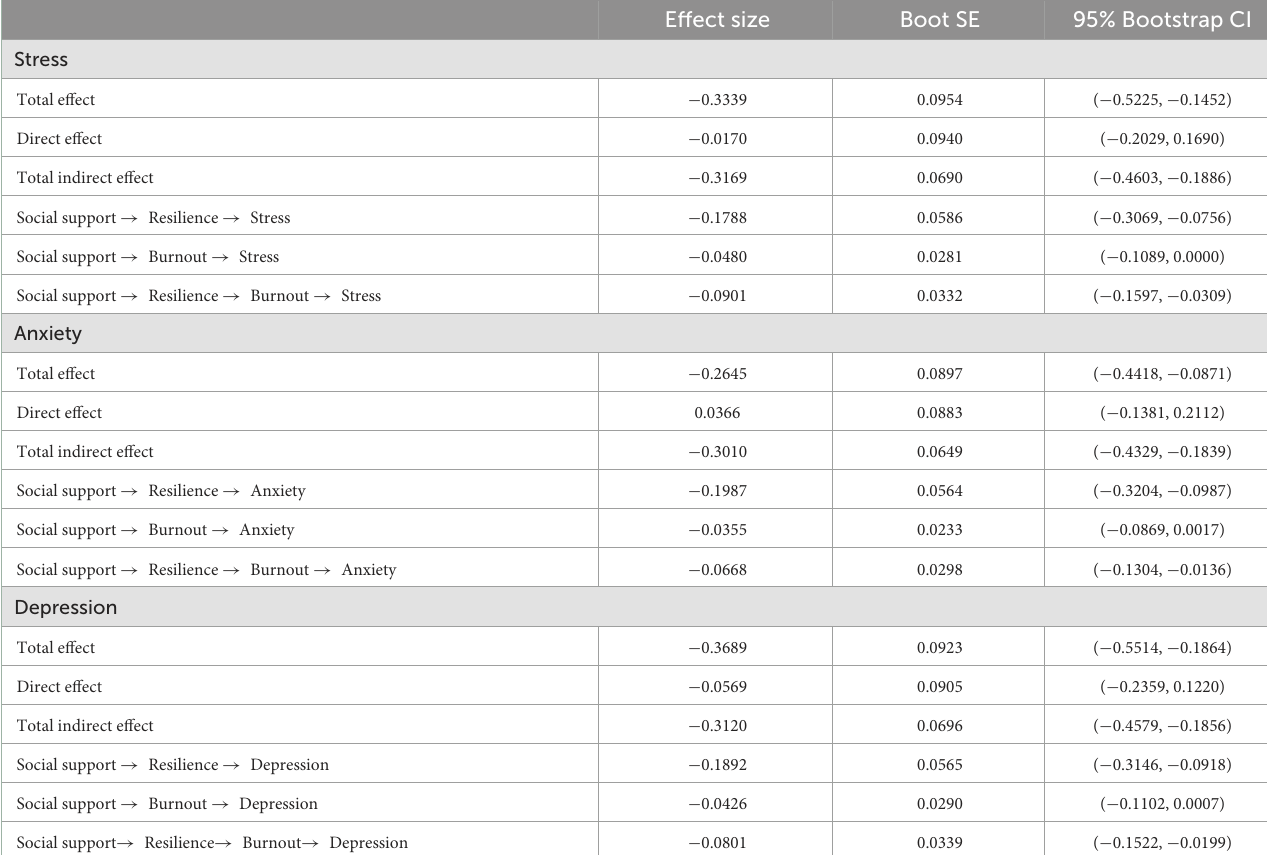
TABLE 4 Bootstrap analysis of mediating effect test between social supports and negative